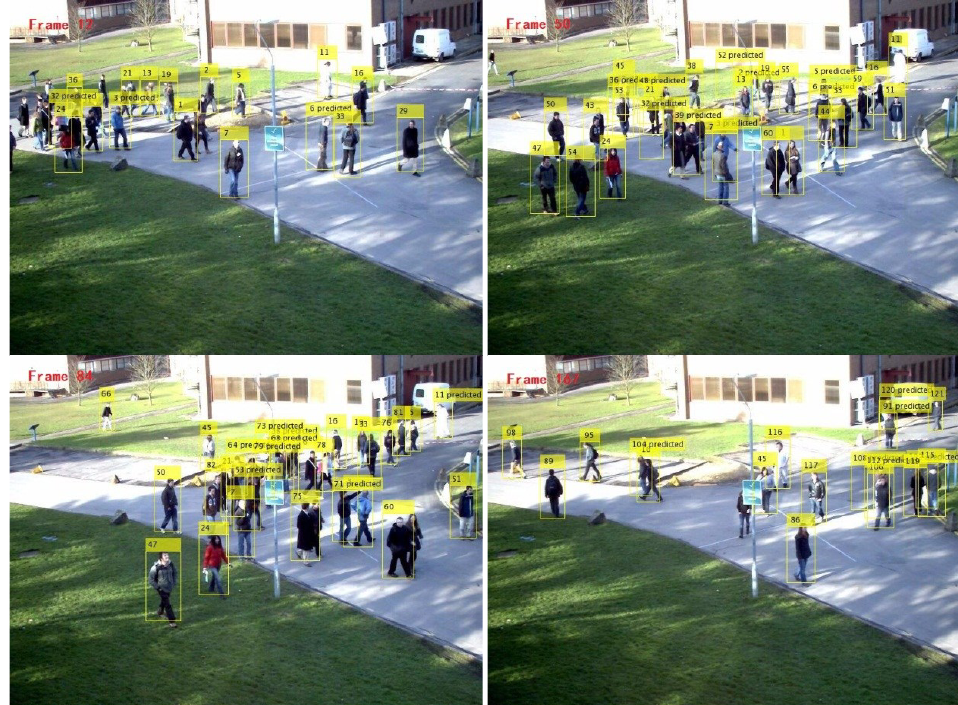
Figure.5. Results of the proposed algorithm on PETS.S2L2